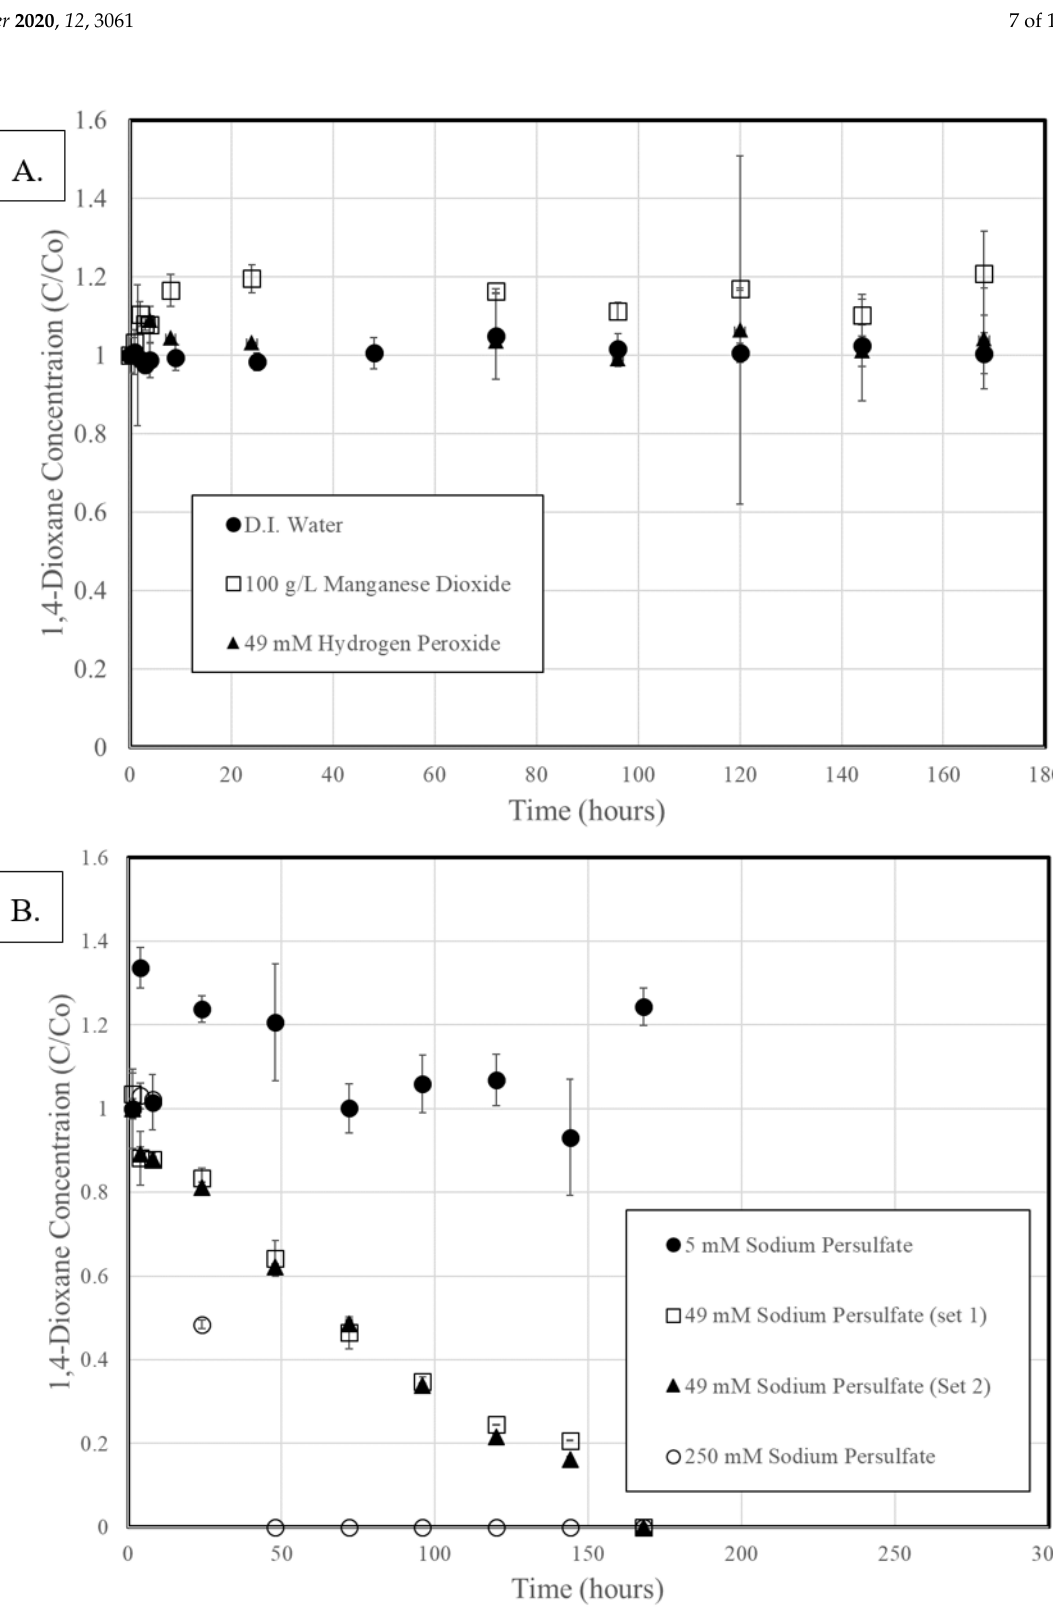
Figure 3. ( A ) Relative concentration as a function of time for control experiments, and ( B ) experiments used to quantify removal kinetics of 1,4-dioxane (1,4-D) using different persulfate concentrations (without manganese activation). Relative concentrations were normalized by the initial 0.5 mM 1,4-D. Set 1 and 2 are replicate experiments. Error bars represent the standard deviation of triplicate samples.